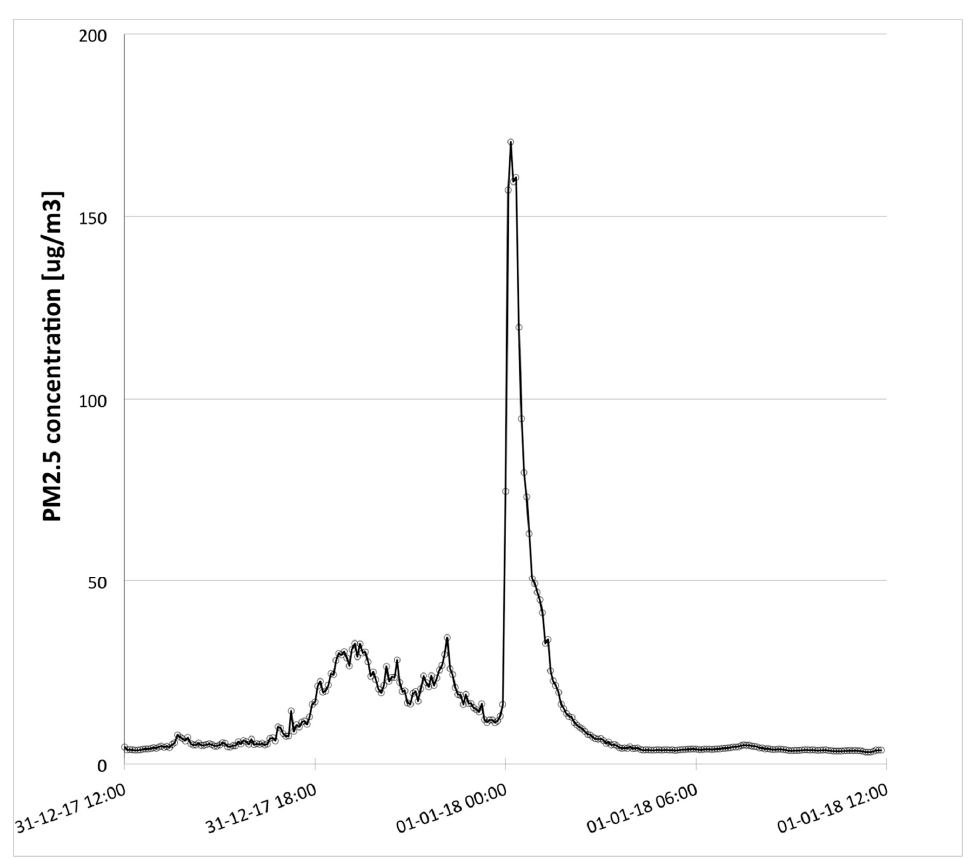
Figure 2. Average PM2.5 concentration measured by approximately 300 dust sensors between 31 December 2017, 12:00 (MET) and 1 January 2018, 12:00 (MET).